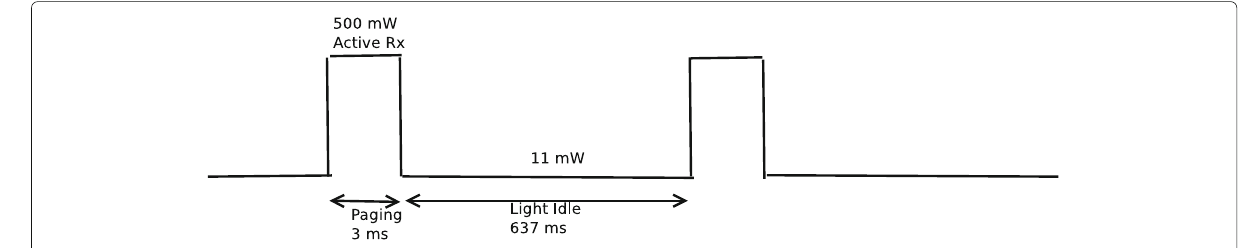
Fig. 11 Modem power profile for a typical paging